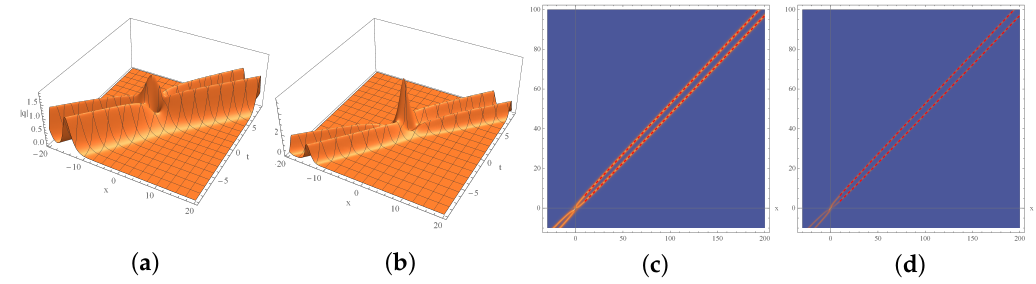
Figure 5. Solution obtained from generalized Darboux transformation.